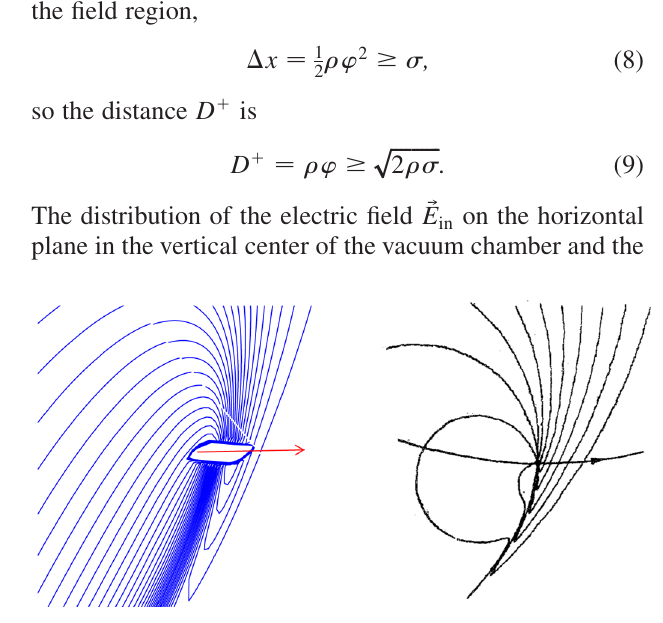
FIG. 6. Fine structure of the field pattern in front of a bunch. The left plot shows field lines near a bunch. The right plot presents a picture from Ref. [20] for (cid:5) ¼ 6 . The plots are rotated and scaled in order to have the same direction for the velocities and approximately the same bending